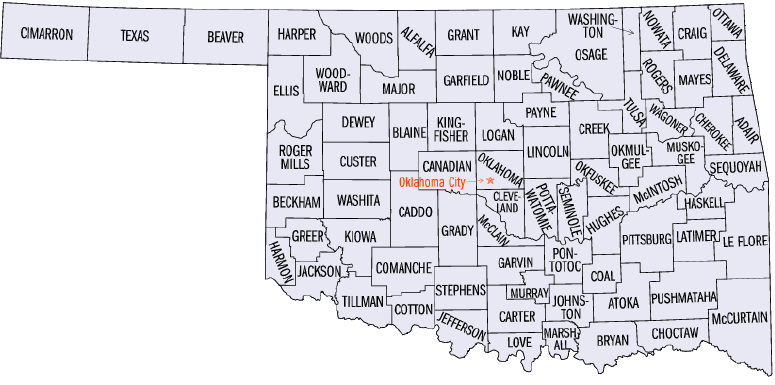
Figure 6. Counties of the State of Oklahoma [26].